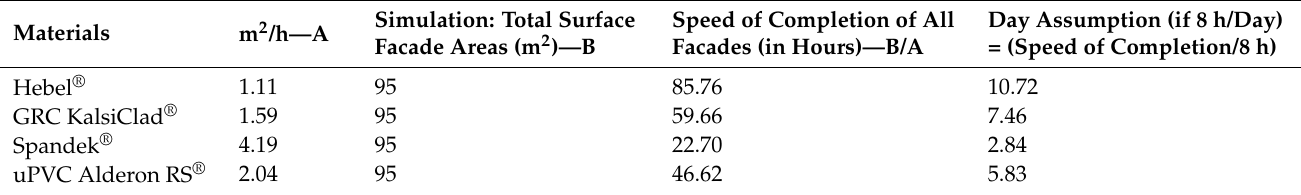
Table 4. Cladding installation duration for the entire LSF